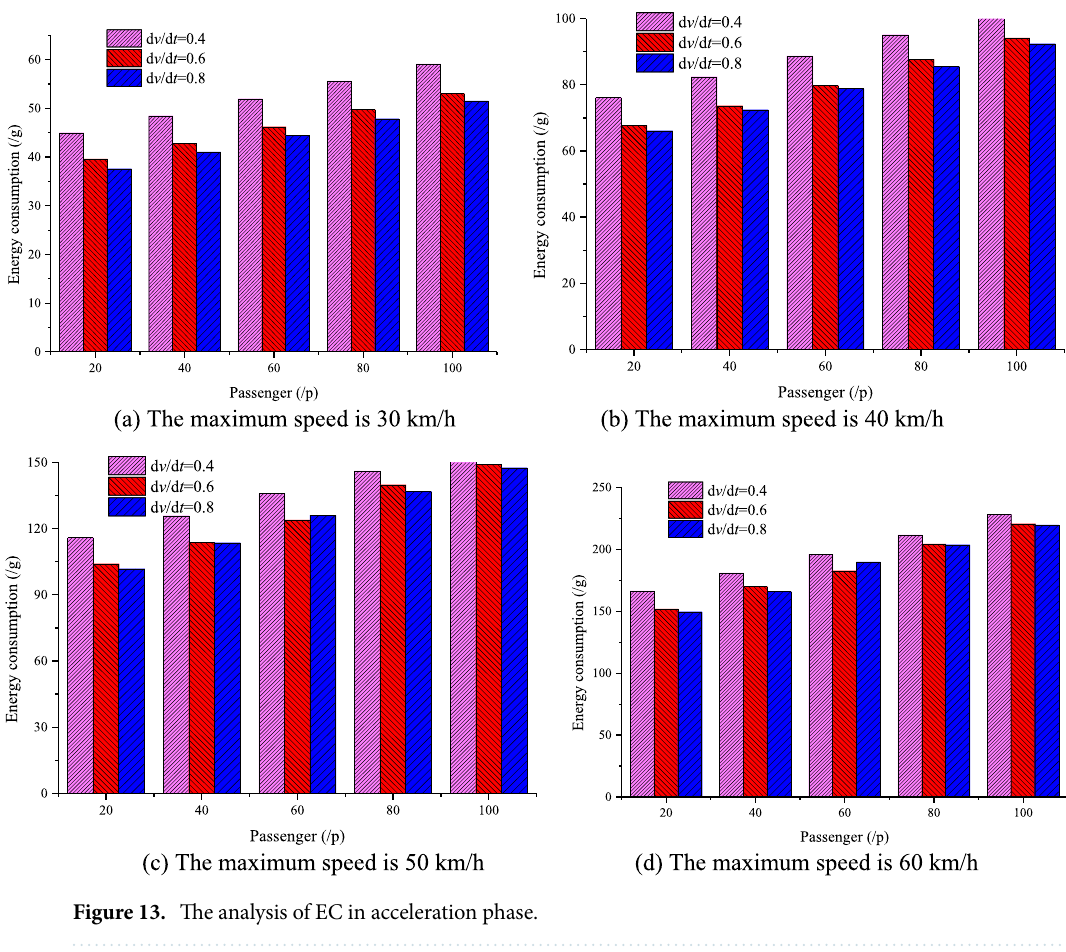
Figure 13. The analysis of EC in acceleration phase.